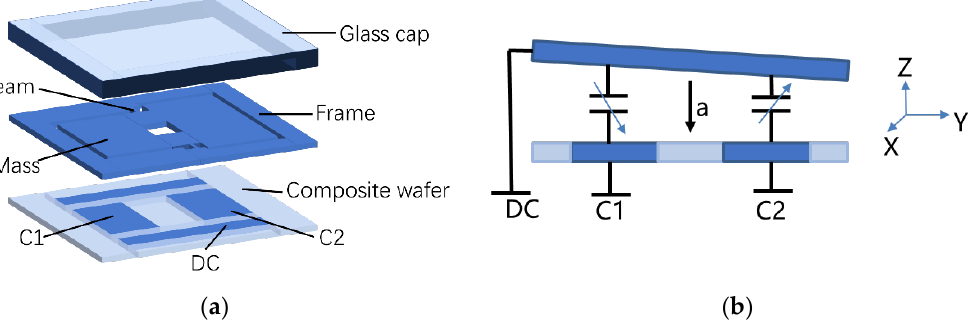
Figure 1. Sketch of the teeter-totter accelerometer. ( a ) Sketch of the teeter-totter accelerometer. ( b ) Working principle of the accelerometer.